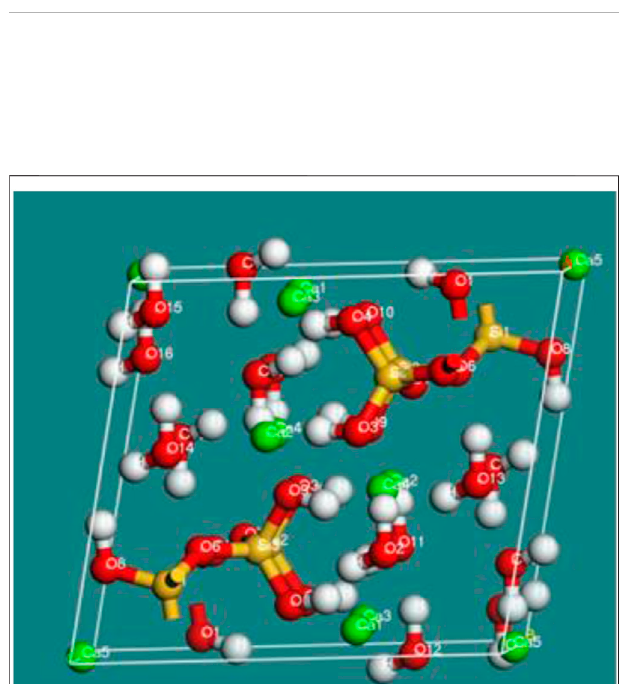
FIGURE 3 | Model of the jennite